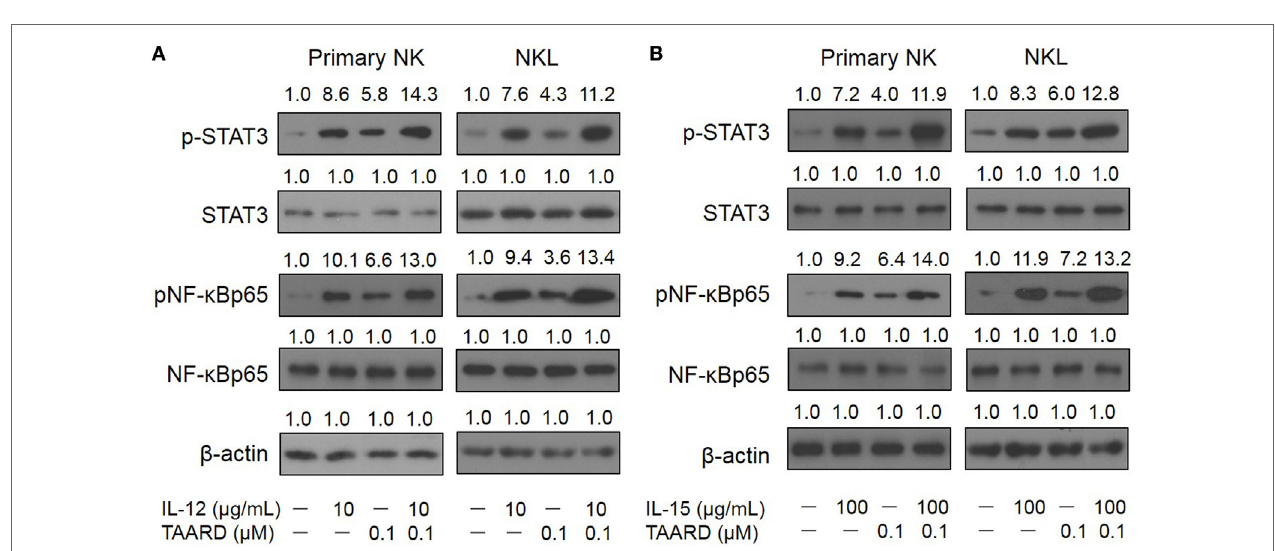
FigUre 3 | TAARD induces the phosphorylation of NF- κ B and STAT3 in NK cells. (a,B) Purified primary human natural killer cells and NKL cells were treated with 0.1 µM of TAARD alone or in combination with 10 ng/mL of IL-12 (a) or 100 ng/mL of IL-15 (B) for 6 h. Cells were harvested and lysed for immunoblotting using their corresponding Abs. β -actin was included as internal control.